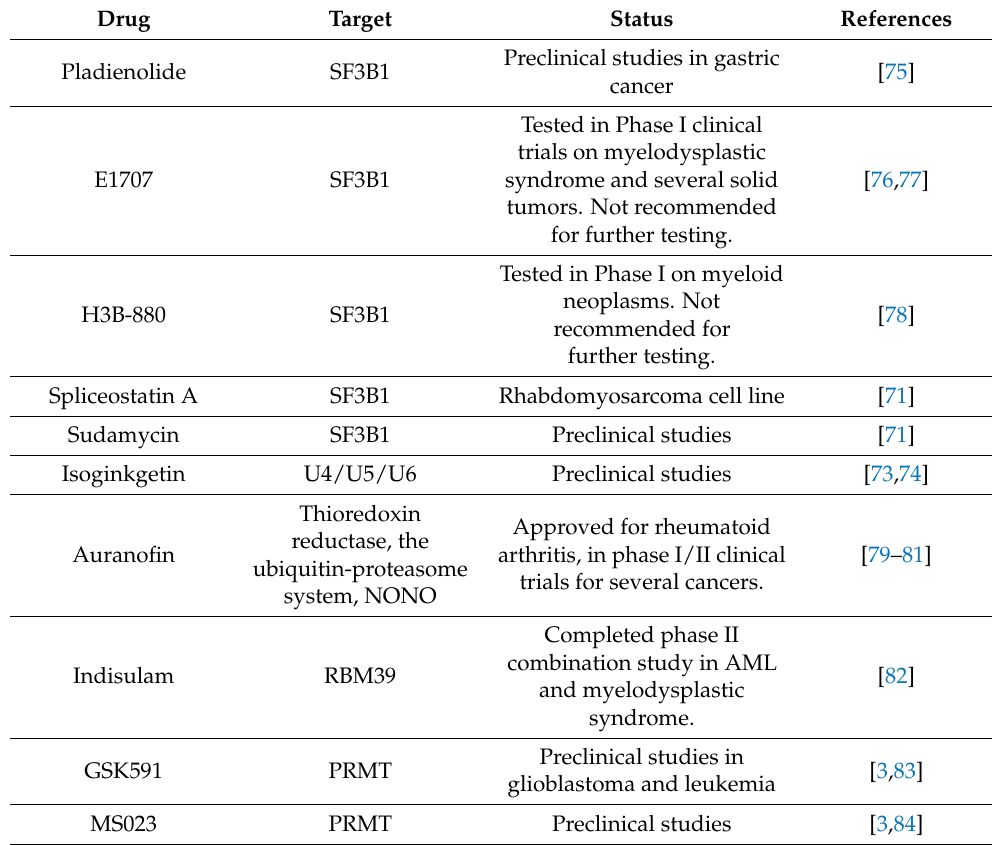
Table 1. Small molecule inhibitors of trans-acting splicing